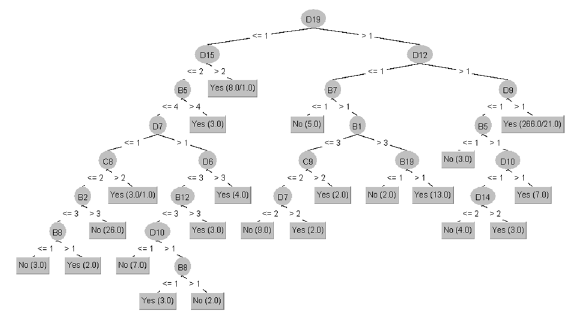
Figure 3. Classifier tree visualizer. Tree J48 from WEKA.